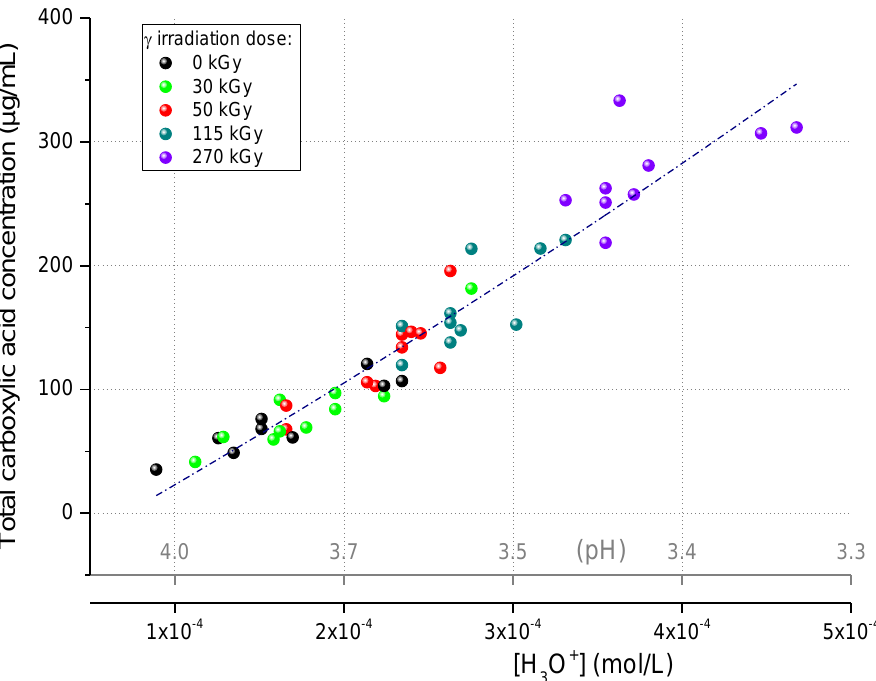
Figure 2. Non-irradiated and γ-irradiated 2,6-di-tert-butyl-p-cresol in solid phase (left to right: 0, 25, 50, 100, and 250 kGy) .